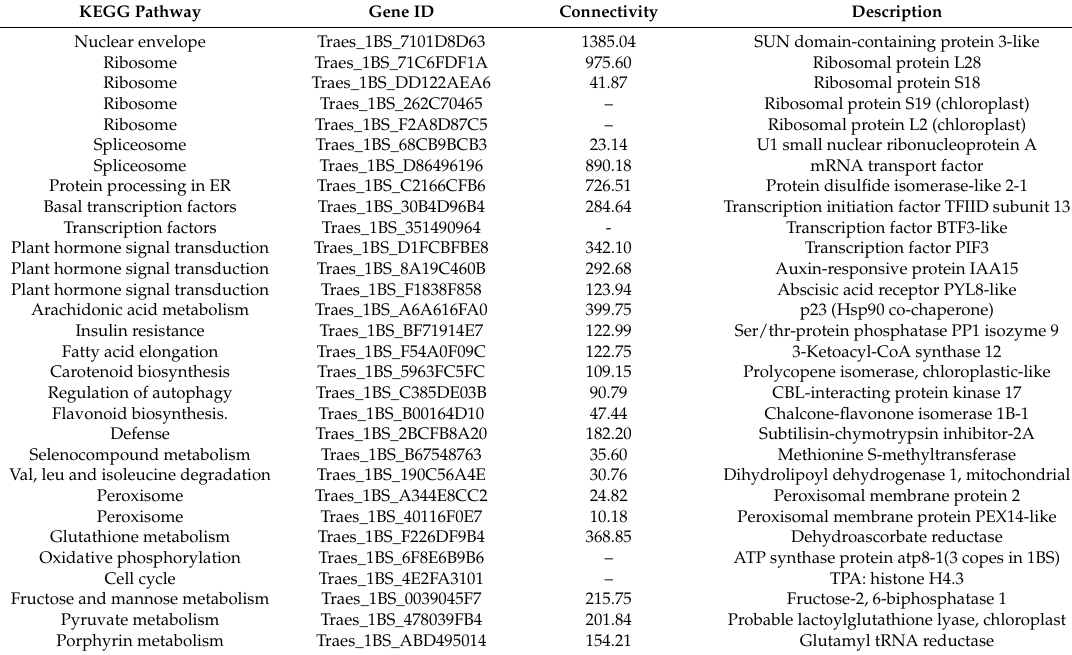
Table 2. The predicted candidate resistance priming gene in wheat variety